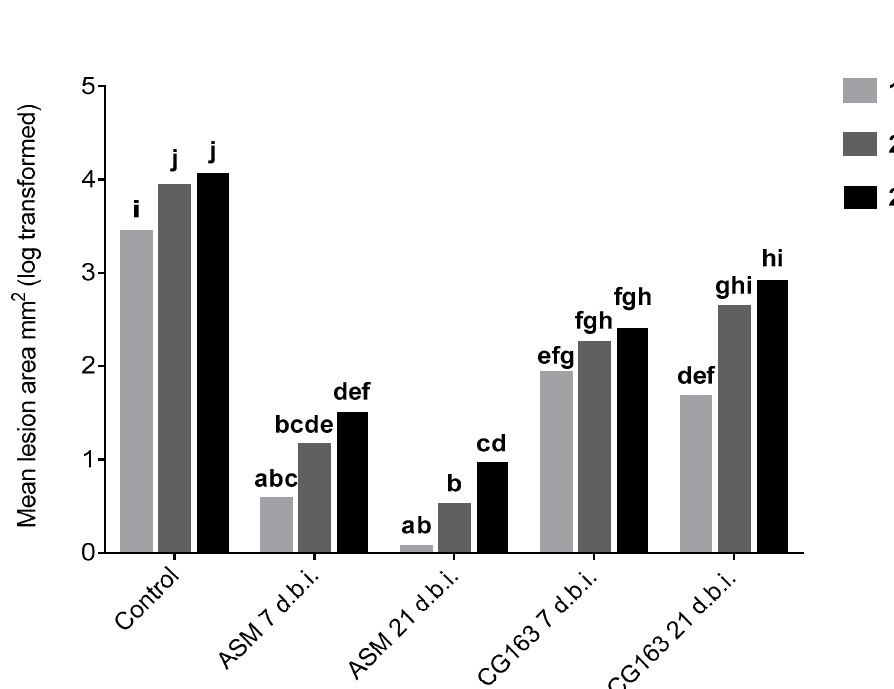
Figure 2. Mean lesion area in Actinidia chinensis var. deliciosa ‘Hayward’ potted plants treated with acibenzolar-S-methyl (ASM), Aureobasidium pullulans strain CG163 (CG163) or untreated (control) 21 or 7 days before inoculation (d.b.i.) with 2 × 10 7 CFU / mL Pseudomonas syringae pv. actinidiae . Disease symptoms were assessed 14, 21 and 28-days post inoculation. Values are means of 12 biological replicates with six inoculation spots on three leaves. Each biological replicate consisted of an average of six inoculation spots on three leaves per rep. Plant replicate was included as a block e ff ect for statistical analysis. Bars with di ff erent letters, based on log-transformed means are significantly di ff erent according to Fisher’s Least Significant Di ff erence test (LSD) at the 5% level.